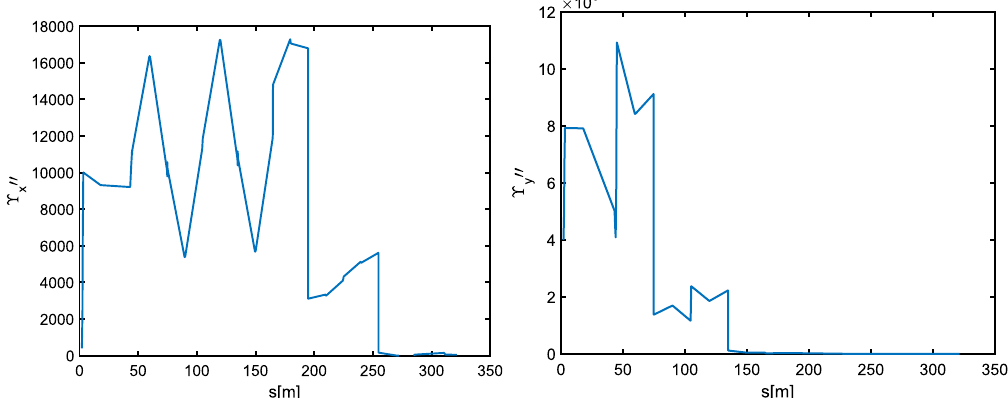
FIG. 14. The second derivative of the Sands ’ mismatch parameter ϒ as a function of s in the horizontal (left) and vertical (right) planes.